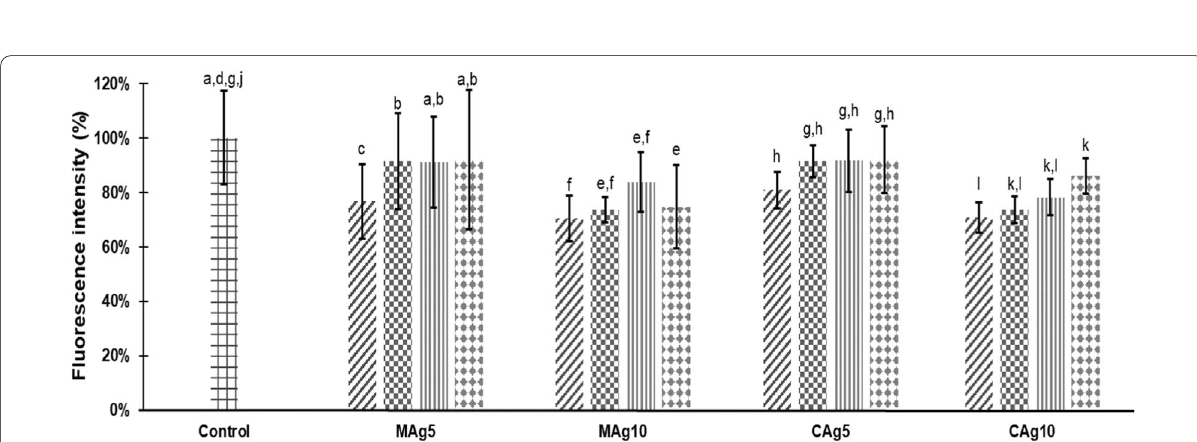
Fig. 5 In vivo antioxidant activities of carotenoid microcapsules stored for 3 months. Results are expressed as the percentage of fluorescence in relation to control nematodes, which were not exposed to microcapsule treatments. “White rectangle” (Untreated); “Division slash” (No storage, freshly spray‑dried); “Filled rectangle” (Storage at 4 °C without access to daylight); “Vertial lines” (Storage at 25 °C in daylight); “Filled diamond” (Storage at 25 °C without access to daylight). Statistical significance of differences ( α 0.05) between control and treated nematodes were = determined by ANOVA (Letters between bars indicate significant